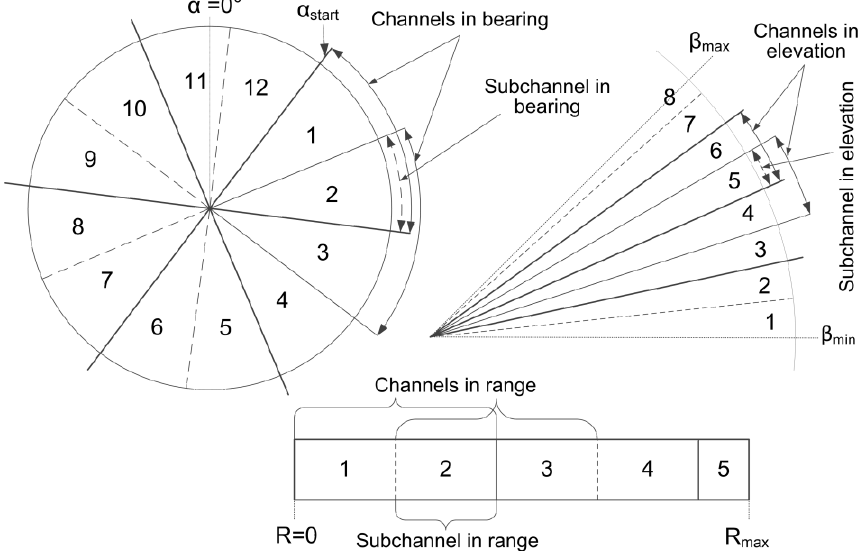
Fig. 3. The example of channel fragmentation of the field αβ RV r . The fragmentation in V r coordinates is analogic to shown in fig.